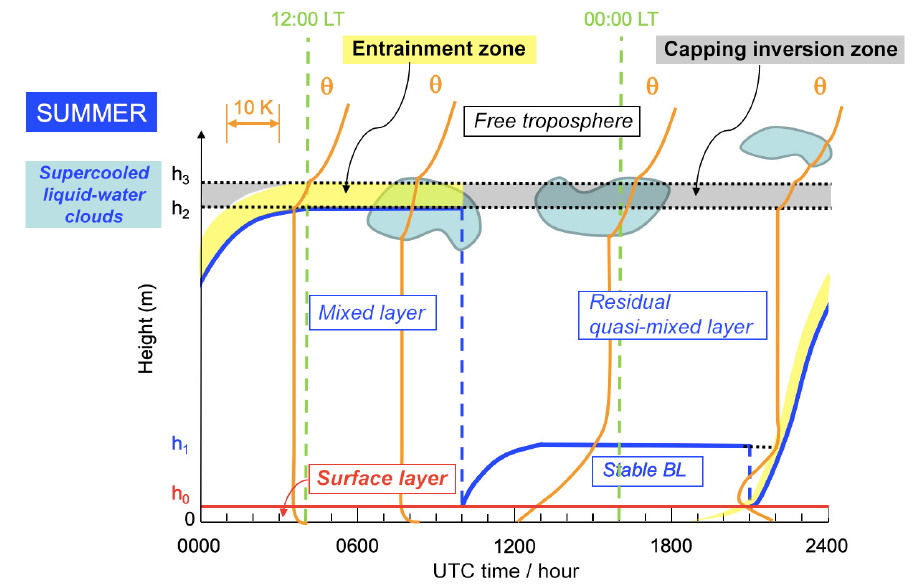
Figure 18. Figure modified and updated from Fig. 12 of Ricaud et al. (2012) showing the diurnal evolution (UTC time) of the different layers in the planetary boundary layer (PBL) with h 0 the top of the surface layer, h 3 the daily overall top of the PBL, and h 1 the top of the intermediate stable layer within the PBL. The orange lines symbolize the vertical profiles of potential temperature θ and the light blue areas the SLW clouds. The layer between h 2 and h 3 is named “capping inversion zone”. The yellow area represents the “entrainment zone” at the top of the (cloudy or cloud-free) mixed layer. When the mixed layer is fully developed, the entrainment zone coincides with the capping inversion zone. Note that LT = UTC + 8h, midnight and noon in the local time reference being indicated by the green dashed